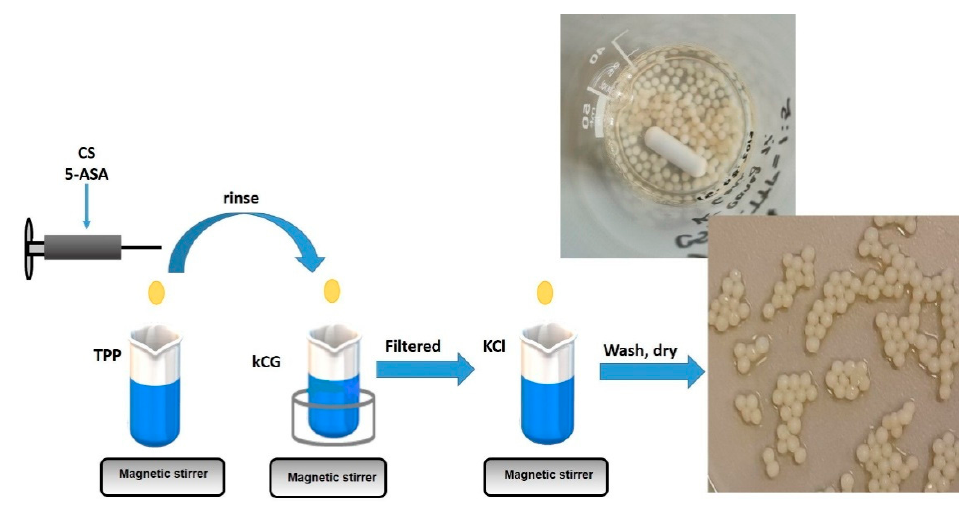
Figure 1. Synthesis route of CS-kCG drug loaded hydrogel beads.